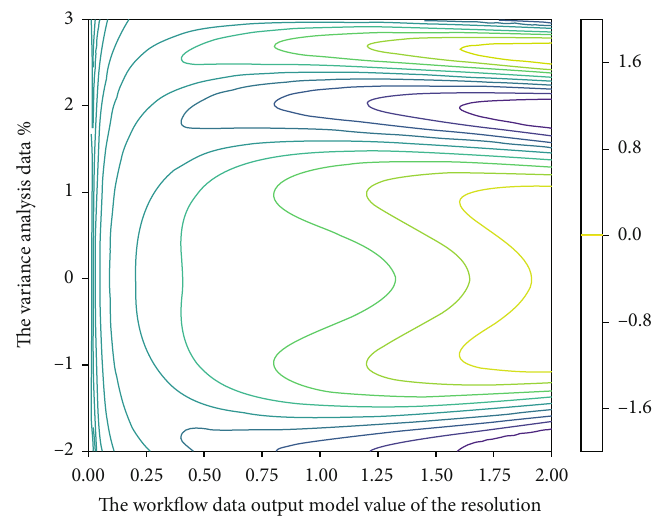
Figure 7: Work fl ow data output di ff erence analysis.